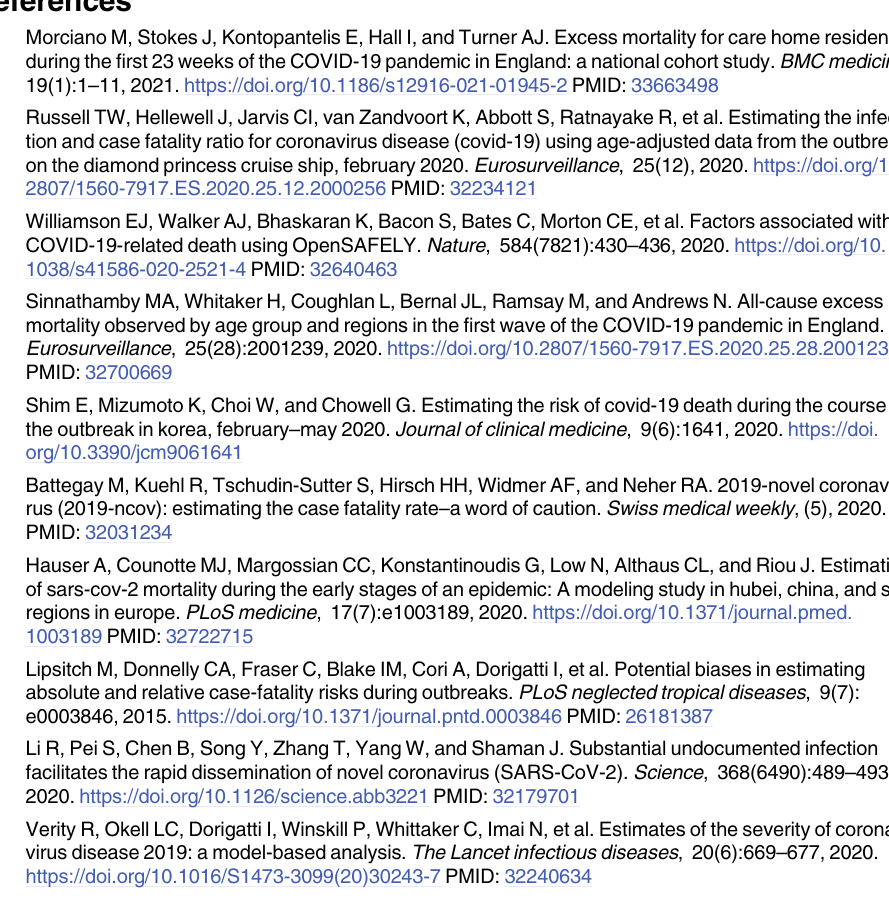
S5 Text. Results for the risk ratio and relative error